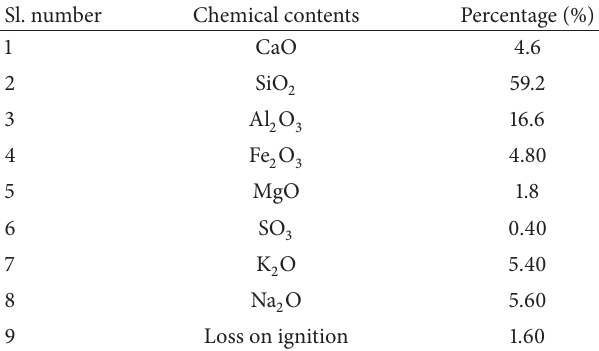
Table 1: Properties of